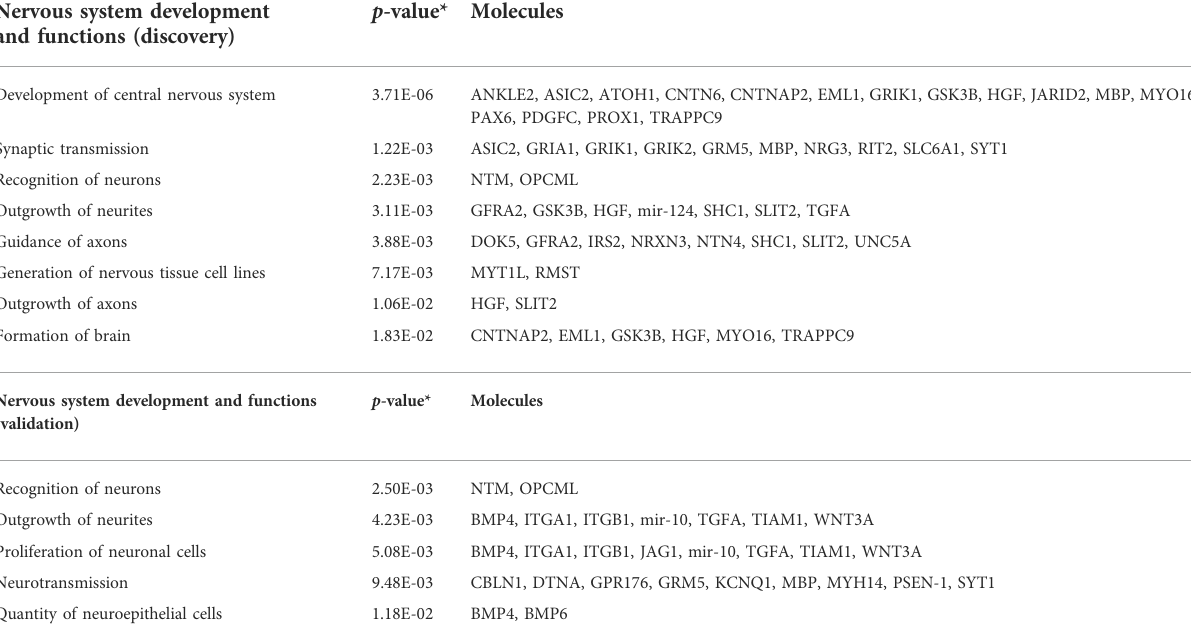
TABLE 3 Nervous system functions enriched among DDE DMR-associated genes from discovery and validation data sets. Nervous system development and functions